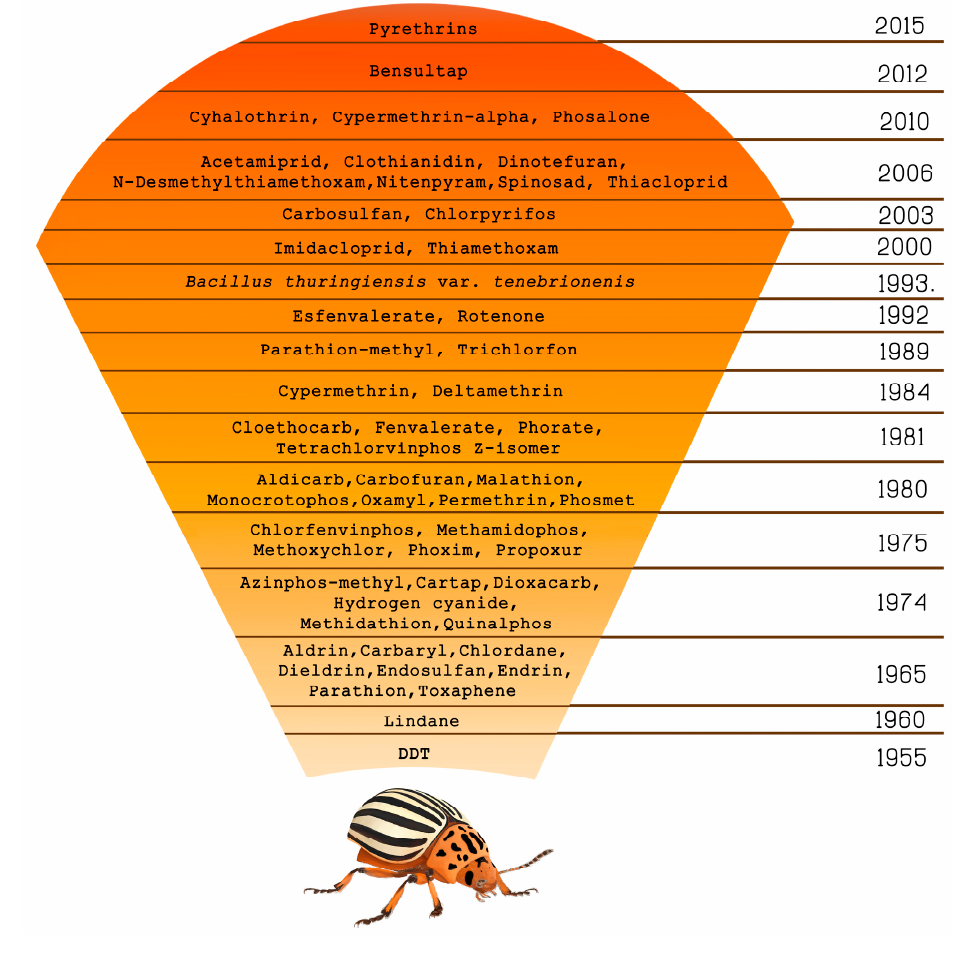
Figure 2. Timeline of resistance development in Colorado potato beetle.